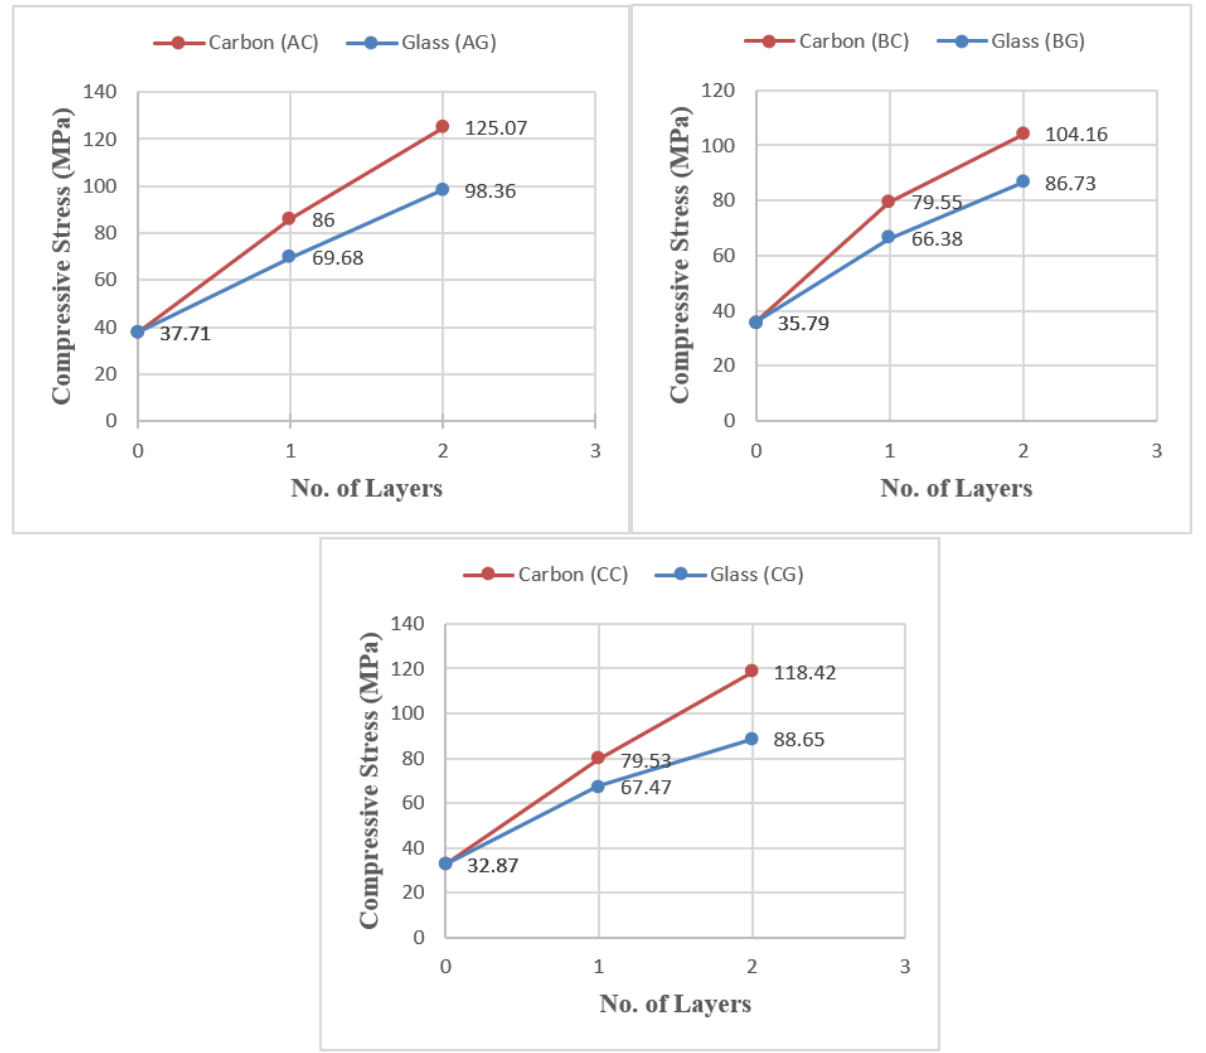
Figure 8: Graphs of compressive strength versus no. of layers for gorups A (4+2 mm), B (3.18+1.4 mm), and C (2+1 mm)